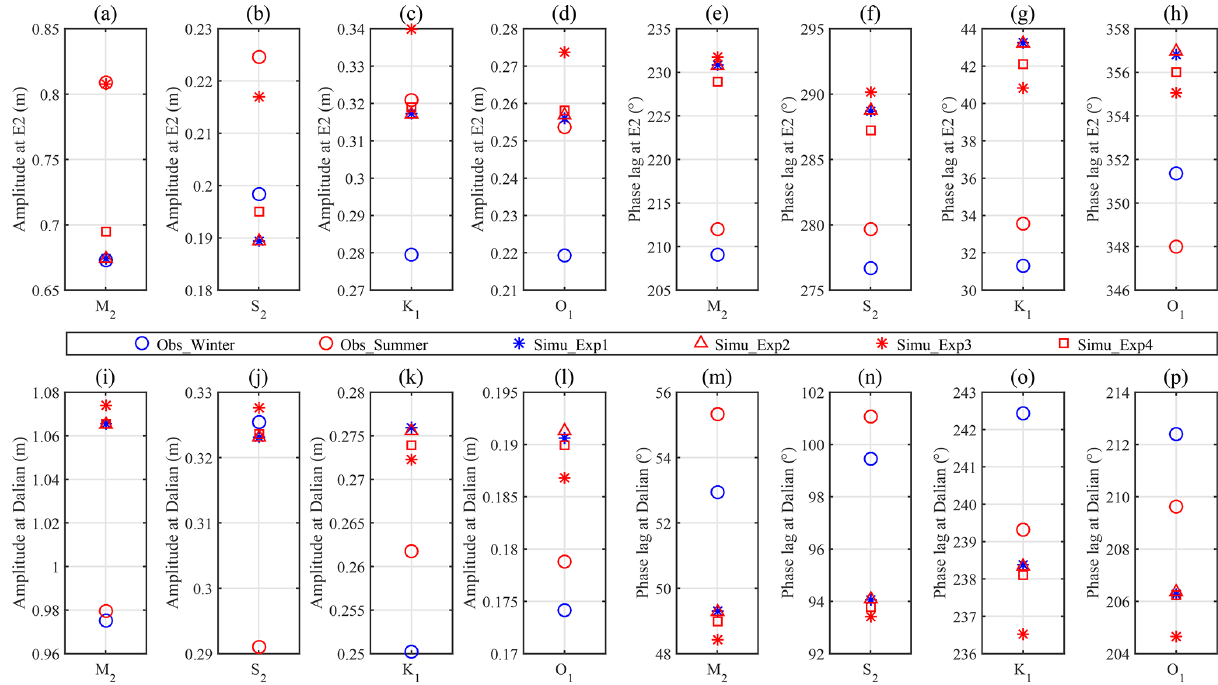
Figure 9. (a) Averaged M 2 amplitude in winter (blue circle) and summer (red circle) by analysing observations at E2 using EHA and those obtained by analysing the simulated results in Exp1 (blue asterisk), Exp2 (red triangle), Exp3 (red asterisk), and Exp4 (red square). Panels (b) – (d) similar to (a) but for S 2 , K 1 , and O 1 at E2, respectively. Panels (e) – (h) similar to (a) – (d) but for the phase lags at E2. Panels (i) – (p) similar to (a) – (h) but for those at